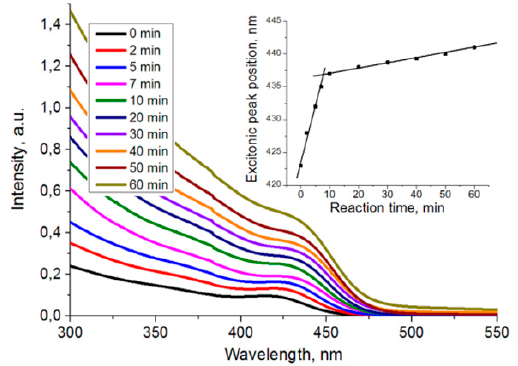
Figure 3. Absorption spectra of Cd 0.9 Mn 0.1 S nanoparticles at various synthesis times.